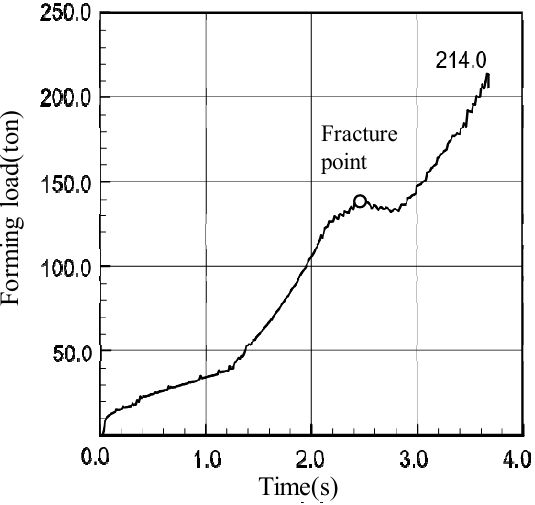
Figure 10. Forming load-time curve.